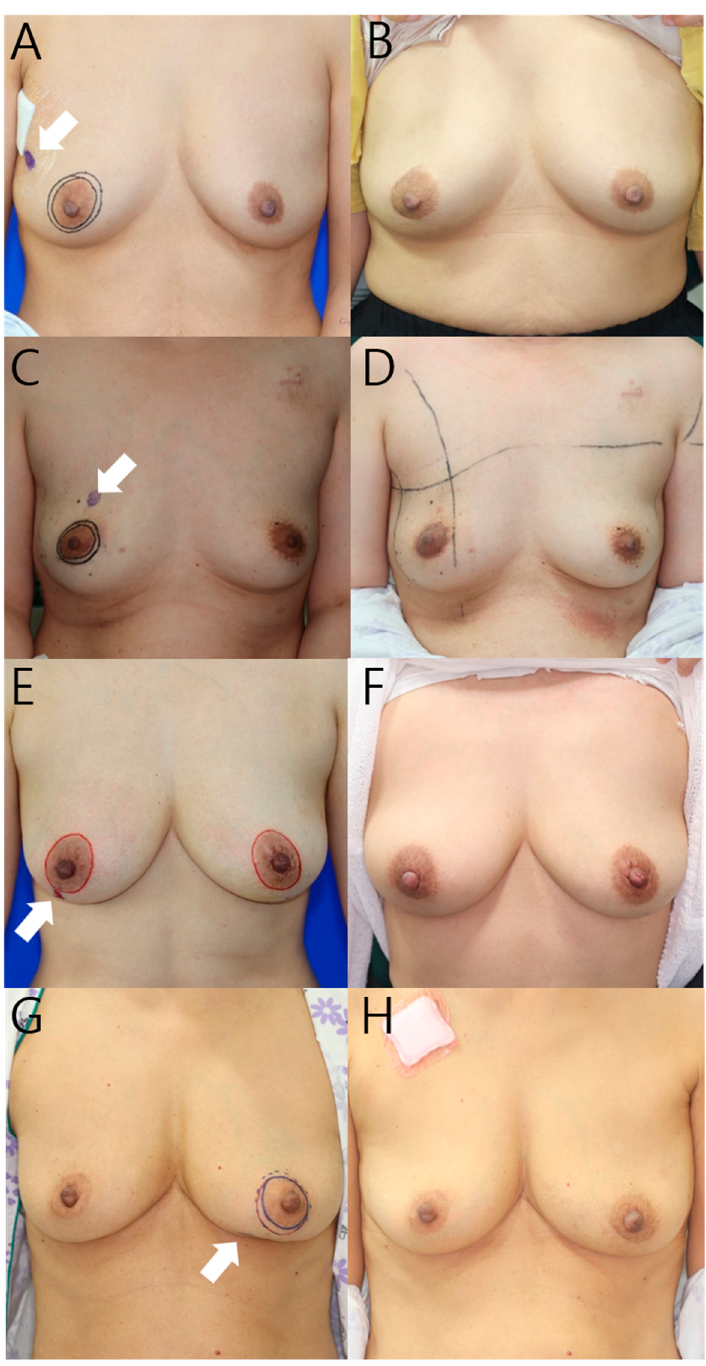
Figure 3. Preoperative ( A,C,E,G ) and postoperative ( B,D,F,H ) 12-month photographs listed by tumor location. White arrow indicates tumor location. ( A ) This 52-year-old patient’s tumor is located in the upper outer quadrant of the right breast, and the resected breast tissue was 22 g, and one ADM was used; ( C ) This 40-year-old patient’s tumor is located in the upper inner quadrant of the right breast, and the resected breast tissue was 21 g, and one ADM was used; ( E ) This 44-year-old patient’s tumor is located in the lower outer quadrant of the right breast, and the resected breast tissue was 28 g, and 2 sheets of ADM were used; ( G ) This 64-year-old patient’s tumor is located in the lower inner quadrant of the left breast, and the resected breast tissue was 18 g, and 2 sheets of ADM were